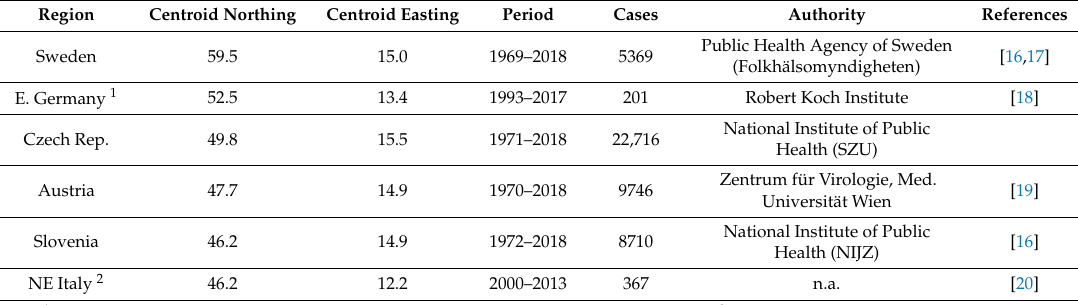
Table 1. Epidemiological